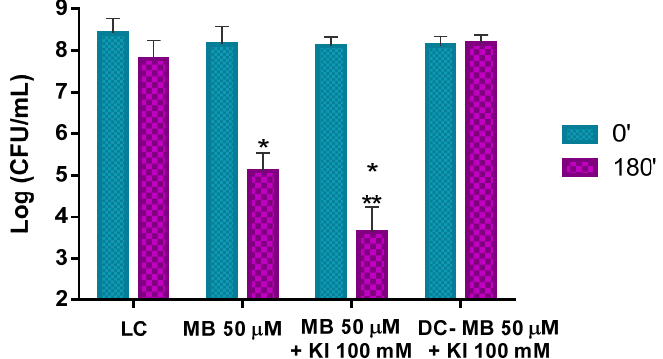
Figure 10. Ex vivo aPDT assay on pollen containing its natural microorganisms plus artificial Psa contamination, irradiated with 50 mW cm − 2 for 180 min, using MB at 50 μ M and MB at 50 μ M with the addition of KI at 100 mM. Values represent the mean of three independent assays; error bars represent the standard deviation. * p < 0.05 (relative to each condition at time 0 ′ ); ** p < 0.05 (relative to MB). LC, light control; DC, dark control.